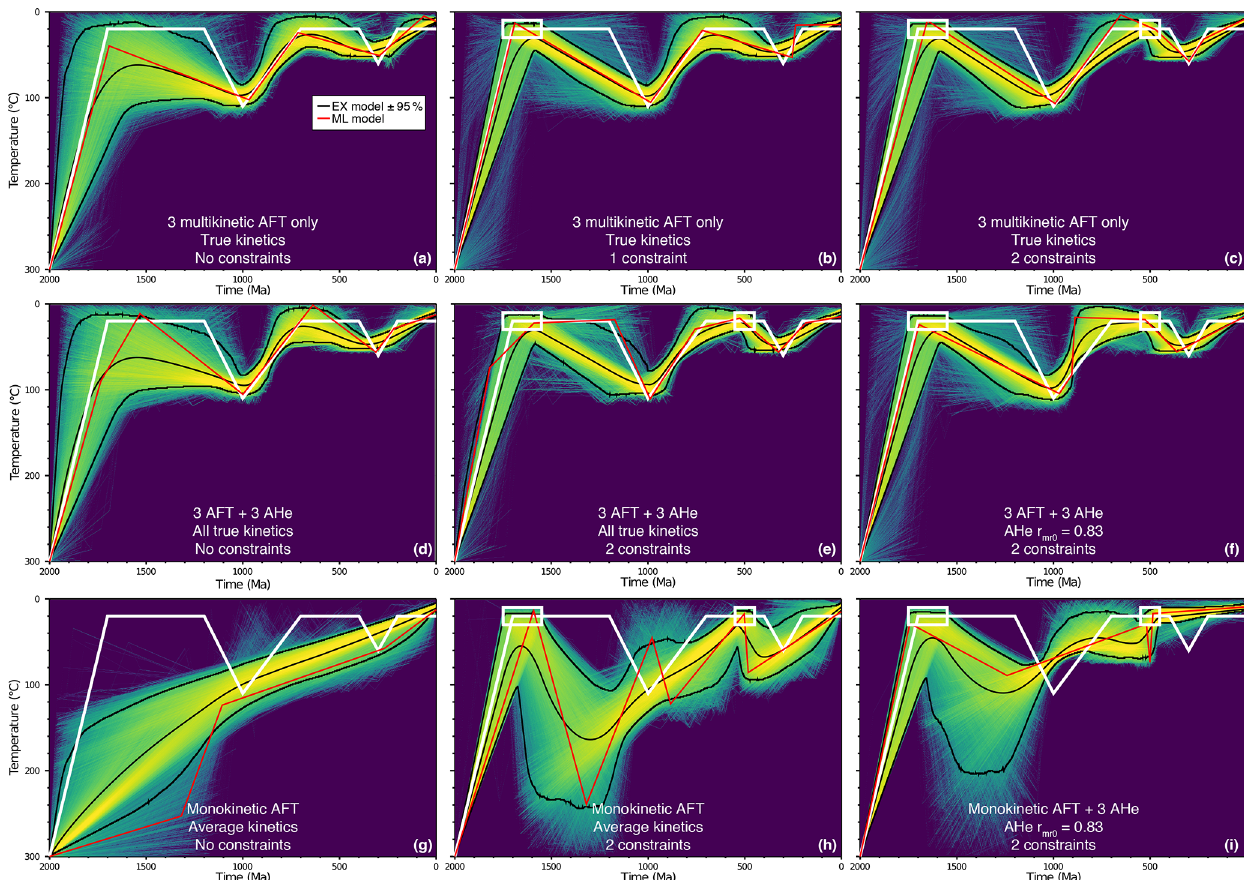
Figure 3. Thermal-history inversion results from QTQt under different imposed kinetic and t – T assumptions. Relative probability is propor- tional to (log) path density in our t – T figures; therefore brighter colours (or higher saturation) denote higher relative probability. Panels (a) – (c) show the “AFT-only” models that utilized three multikinetic AFT populations (discussed in the text) as the only input data. The true r mr0 kinetics applied during forward modelling were entered in the input files and held fixed for each kinetic population during the inversion. Panels (d) – (e) show the results of models that correctly utilized three multikinetic AFT kinetic populations and three AHe ages all with the true kinetics held fixed. Panel (e) is the best model inversion incorporating all correct thermochronometer information used during forward modelling of the synthetic dataset. The panel (f) model was completed under the same conditions as panels (d) – (e) except that the three AHe grains all employ the incorrect (in the oldest and youngest cases) RDAAM default fluorapatite r mr0 value of 0.83 as the kinetic parameter. Panels (g) – (i) were modelled assuming a “monokinetic” or traditional single-population AFT sample that combines all three multikinetic populations into one. For all panels, the thick white line is the “true” thermal history from Fig. 1; red lines are the maximum likelihood model (best fit) t – T path from QTQt; black lines are the expected model t – T path and 95% credible interval. Assumed t – T constraints are white boxes that require thermal histories to pass through them during the